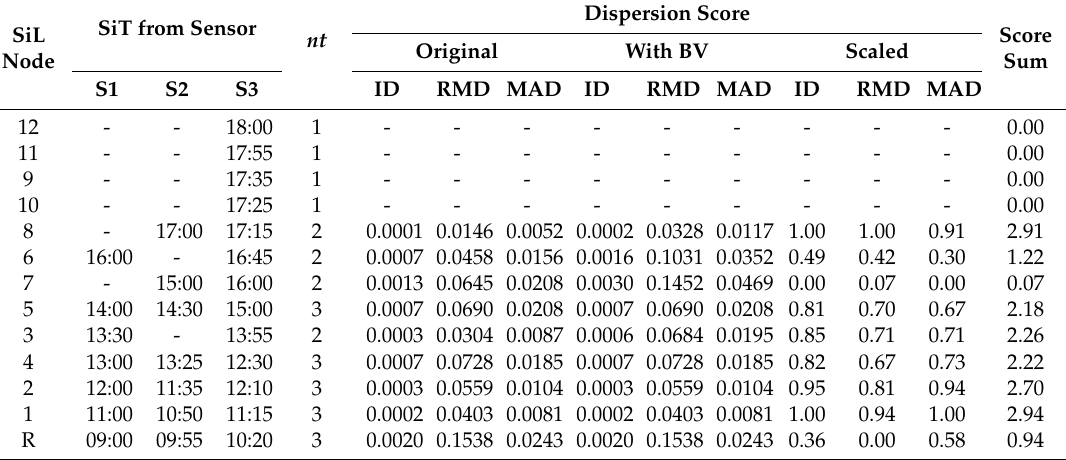
Table 1. Scoring process and output results of the sample